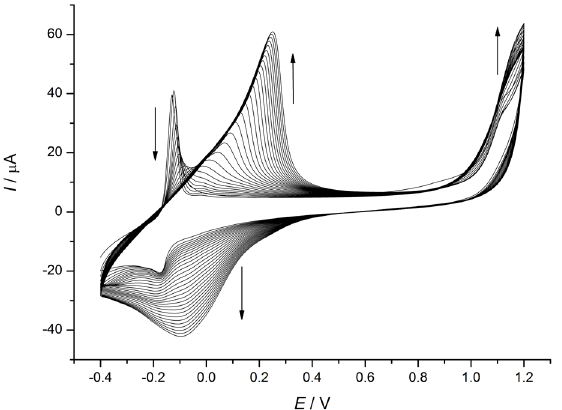
Figure 2 - Voltammetric profile of MB electropolymerization; [MB] = 0.76 mmol L 1 in 0.02 mol L 1 sodium tetraborate and 0.1 mol L 1 NaNO (pH 9.2); 30 cycles between 0.4 and +1.2 V 3 at 0.05 V s 1 .